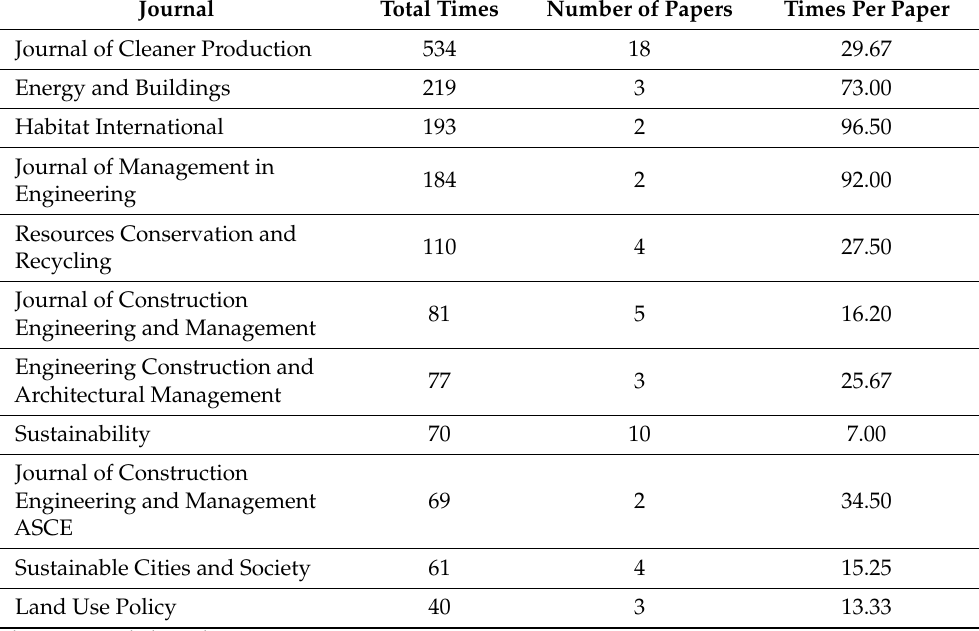
Table 1. Most frequently cited journals on CIP.